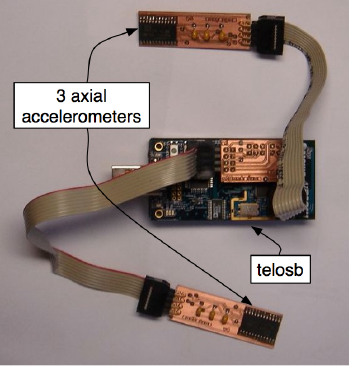
Figure 3. Developed PCB plugged to